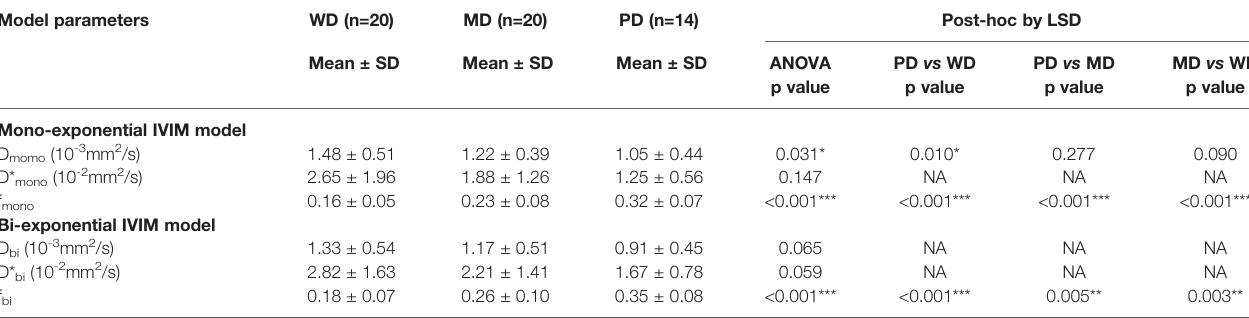
TABLE 1 | The differences between the mono-exponential IVIM model and bi-exponential IVIM model distinguishing the pathological grade of ESCC ( (cid:1) x ± SD). Model